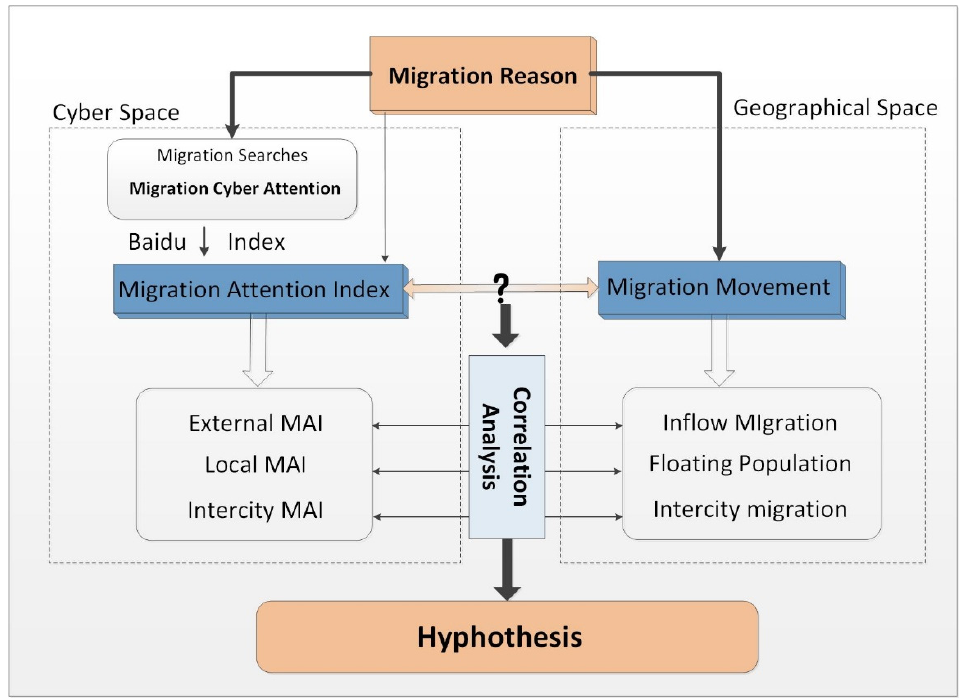
Figure 2. Research Figure 2. Research framework.